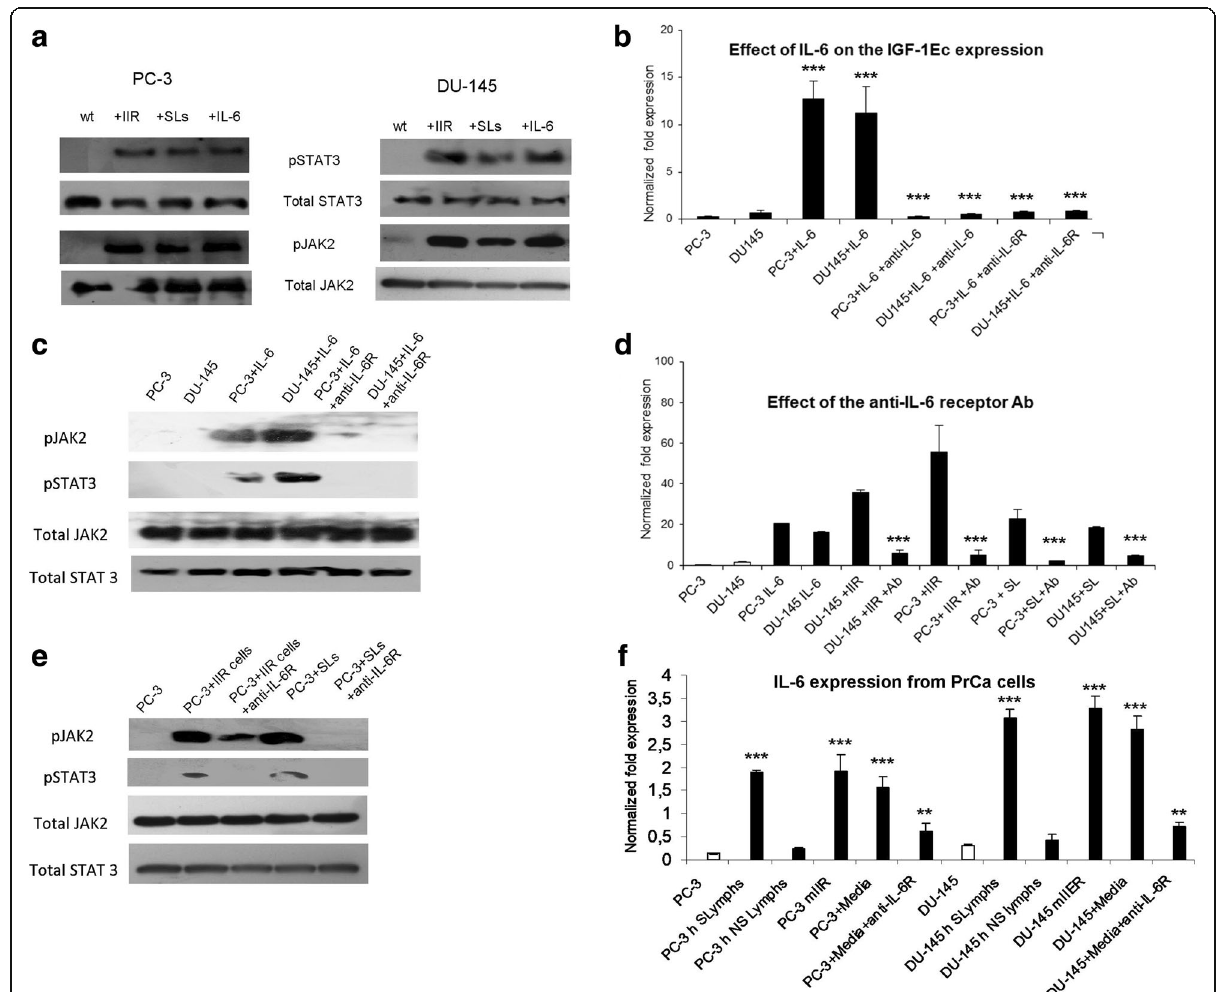
Fig. 3 Determination of the effect of IL-6 on the IGF-1Ec expression. a : Co-incubation of prostate cancer cell lines with the cells of the innate or adaptive immune system (IIR: innate immune response, SL: sensitized lymphocytes) led to JAK2/STAT3 pathway activation as assessed by western blot analysis. b : The exogenous administration of 50 nM of IL-6 for 1 h in both prostate cancer cell lines was associated with a significant increase of IGF-1Ec expression in both cell lines (qRT-PCR). This effect was abolished with the addition of anti-IL-6 or anti-IL-6R antibodies. c : Treatment of PC-3 and DU-145 cells with IL-6 led to the induction of JAK2 and STAT3 phosphorylation as assessed by western blot analysis. This effect was reversed when these cell lines were treated with the anti-IL-6R antibody. d : In both cell lines the IGF-1Ec upregulation resulted after their exposure to the IR cells (innate or adaptive) was reversed when treated with anti-IL-6R antibody (qRT-PCR). e : Effect of the anti-IL-6R antibody on the JAK2 and STAT3 phosphorylation induced by the immune system attack (innate or adaptive) on PC-3 cells (western blot analysis). Antibody treatment led to a significant reduction in the phosporylation status of JAK2 and STAT3. Similar results were observed for the DU-145 cells. F: Both prostate cancer cell lines under the attack of the IR (innate or adaptive) were found to express significant amounts of IL-6 (qRT-PCR) compared to the controls. Conditioned media collected from the co-culturing experiments had the same effect on IL-6 expression when introduced in wt prostate cancer cell lines. The IL-6 upregulation was reversed when the cells were treated with the anti IL-6R antibody (**: p < 0.005, ***: p <